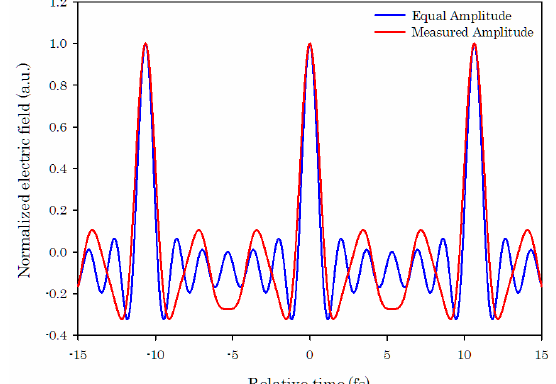
Figure 4. Synthesized waveforms calculated for the six component comb obtained in this experiment (red curve) and for the case where the components are reduced to equal amplitude (blue curve) for the zero detuning case. This will produce a continuous train of pulses of the calculated shape shown here.